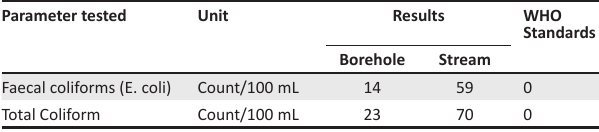
TABLE 1: Laboratory test results of water pollution.